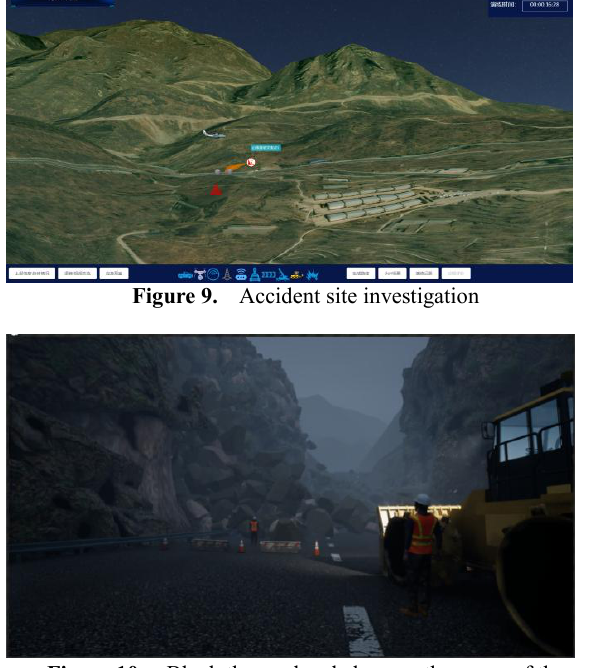
Figure 10. Block the road and clean up the scene of the